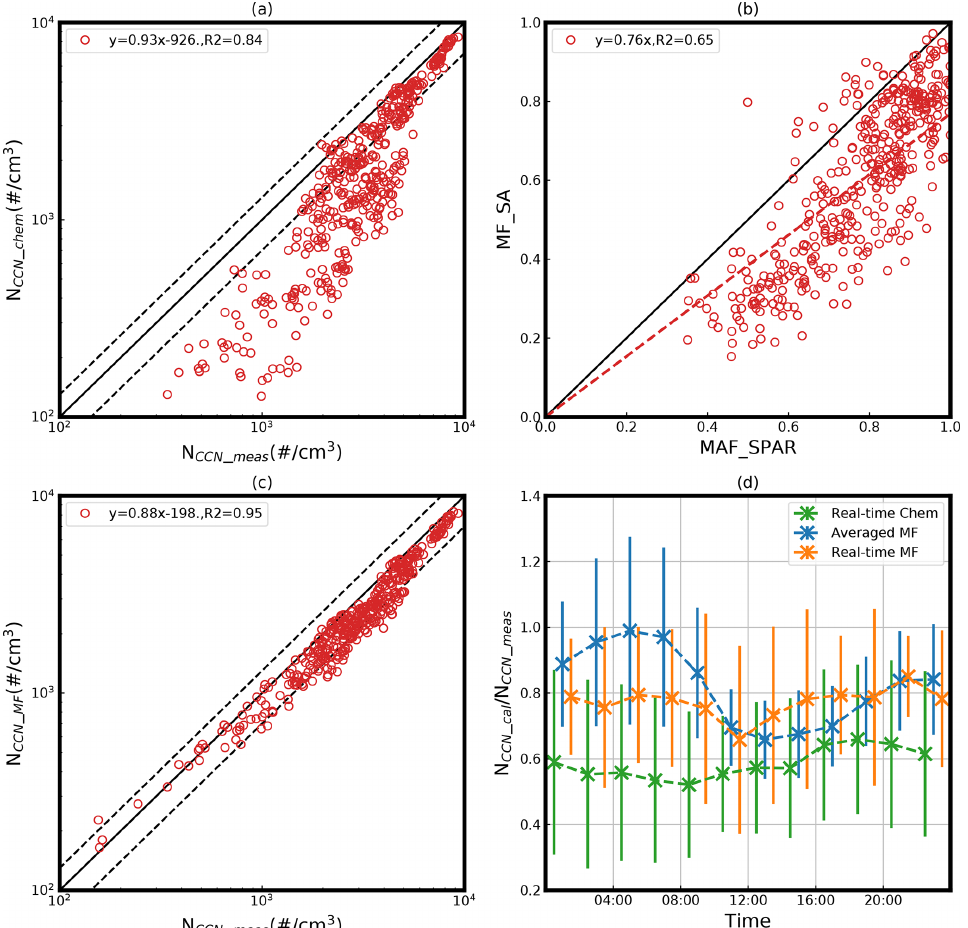
Figure 6. (a) The comparison between calculated N CCN based on κ derived from bulk particle chemical compositions ( N CCN_chem ) and measured N CCN at SS of 0.05%. (b) The correlation between MAF and mass fraction of secondary aerosol (MF SA ). (c) The comparison between calculated N CCN based on SPAR derived from real-time MF SA and average D a ( N CCN_MF ) and measured N CCN . The dashed black lines represent the relative deviation of 30%. (d) The diurnal variations of the ratio between the calculated and measured N CCN during the whole campaign based on different methods (green: N CCN_chem ; blue: N CCN calculated based on SPAR derived from averaged MF SA and average D a ; yellow: N CCN_MF